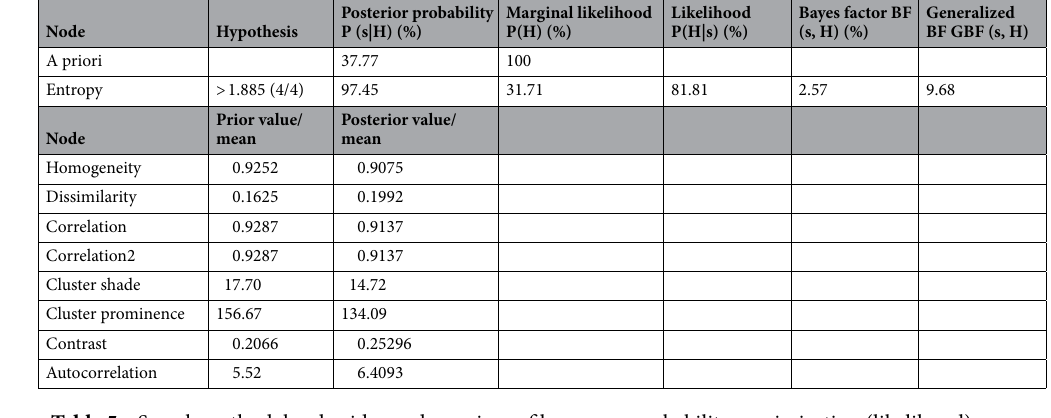
Table 5. Search method: hard evidence dynamic profile energy: probability maximization (likelihood) energy ≤ 0.273 (1/4).